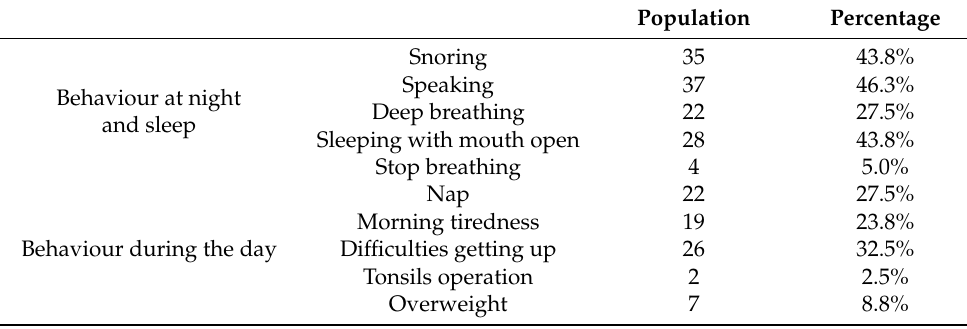
Table 2. Sample distribution of sleep disorders and effects on the